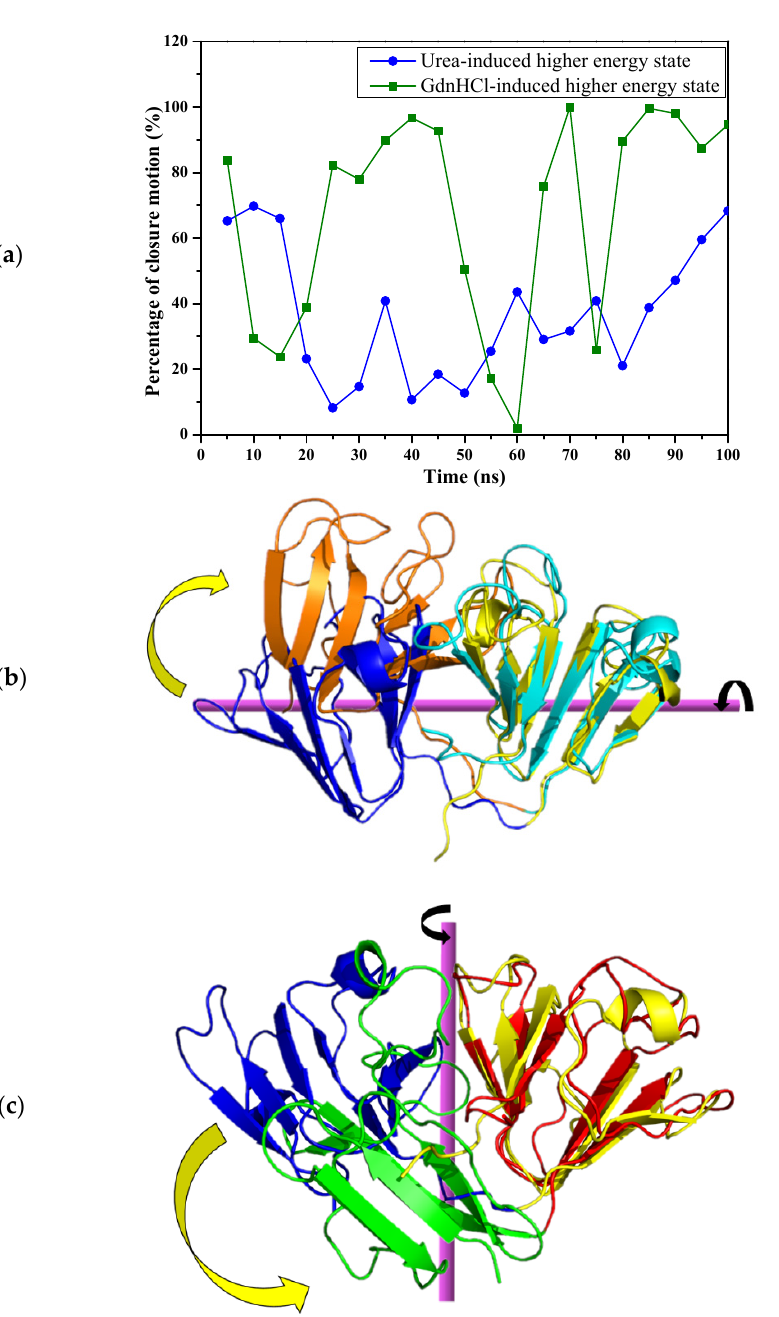
Figure 9. ( a ) Interdomain motions of the HGDC higher energy state structures as a function of simulation time. Superimposition of the C-td domains in ( b ) urea-induced structures and ( c ) GdnHCl-induced structures at the beginning (0 ns) and toward the end (92 ns) of the simulation time. Both the urea- and GdnHCl-induced conformers at 0 ns are colored blue (N-td) and yellow (C-td). The urea- and GdnHCl-induced structures at 92 ns are colored orange (N-td)/cyan (C-td), and green (N-td)/red (C-td), respectively. The hinge axis is presented in violet, the black arrow shows the rotational motion around the axis, and the yellow arrow indicates the motion of N-td with C-td’s of the structures at 0 ns and 92 ns superimposed.